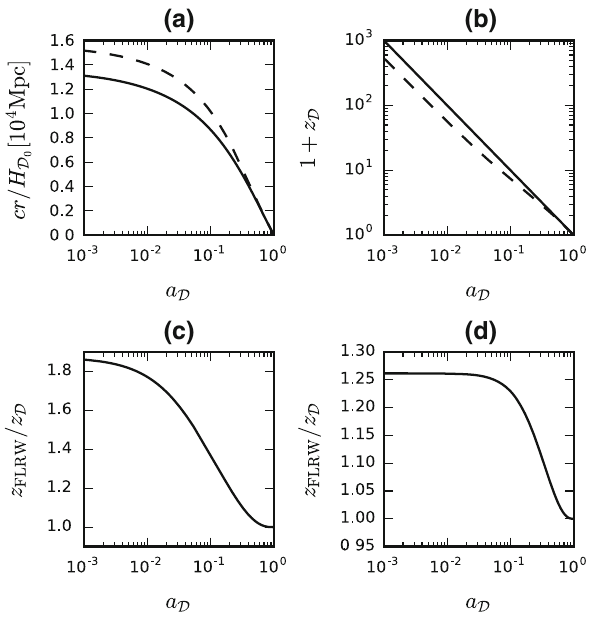
Fig. 1 The evolutions of the coordinate distance cr / H D shift ( b ) and the ratio between the FLRW redshift and the effective red- shift,1 /( a D ( 1 + z D )) ,intheaveragedmodelasfunctionoftheeffective scale factor z D with n = − 1, Ω D 0 m = 0 . 3, H D (dashed line). The flat FLRW model with same parameters are the solid lines shown in ( a ) and ( b ), respectively. d 1 /( a D ( 1 + z D )) for Larena’s best-fit averaged model with n = 0 . 12, Ω D 0 m = 0 . 38, = 78 . 54 km s − 1 Mpc − H D 0